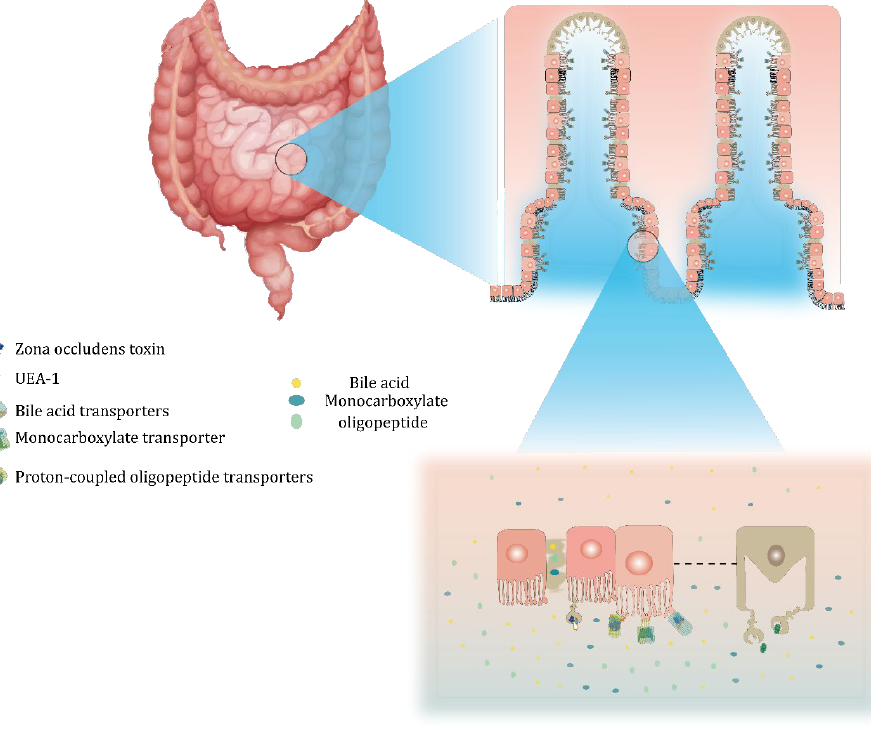
Figure 4. Intestinal absorption mechanism.